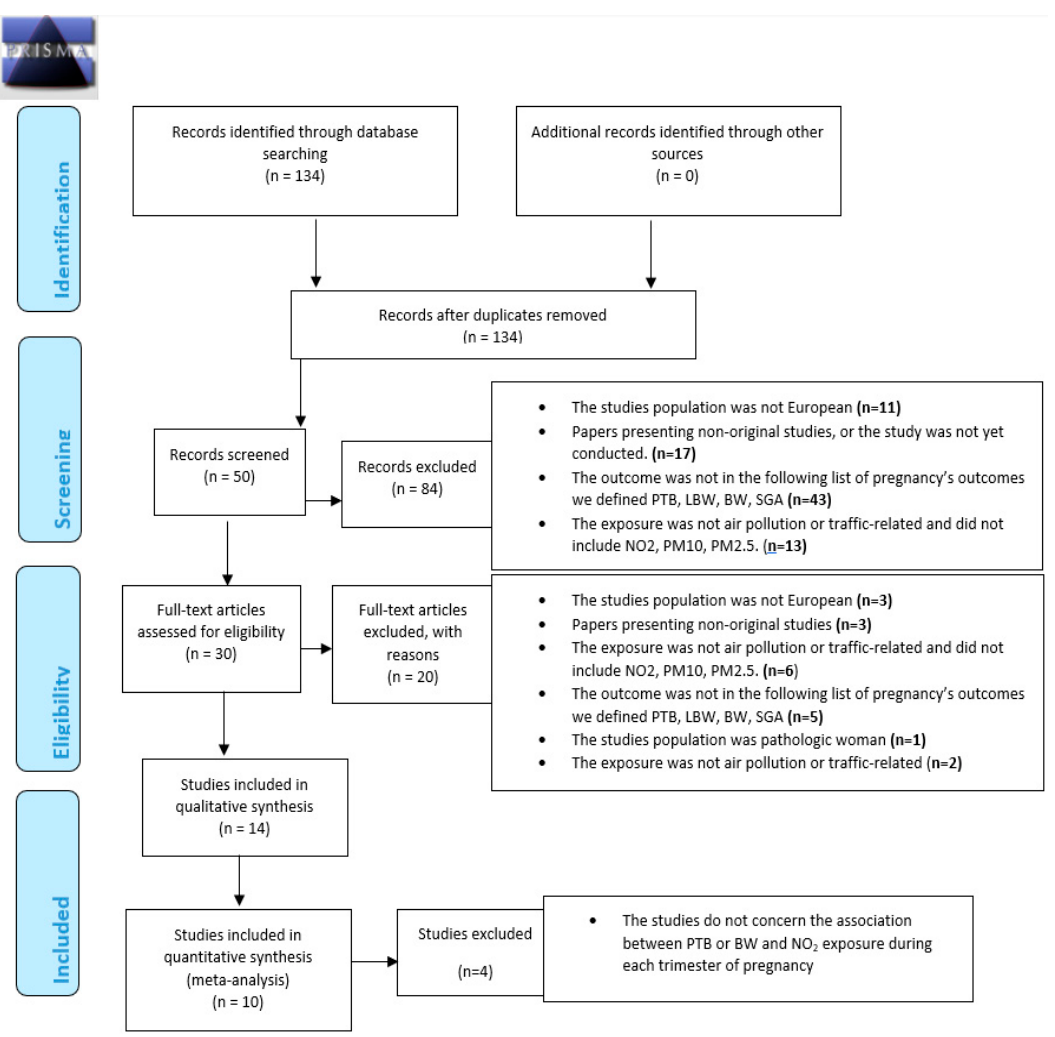
Figure 1. Preferred Reporting Items for Systematic reviews and Meta-Analyses (PRISMA) 2009 Flow Diagram. From: Moher D, Liberati A, Tetzlaff J, Altman DG, The PRISMA Group (2009). Preferred Reporting Items for Systematic Reviews and Meta-Analyses: The PRISMA Statement. PLoS Med